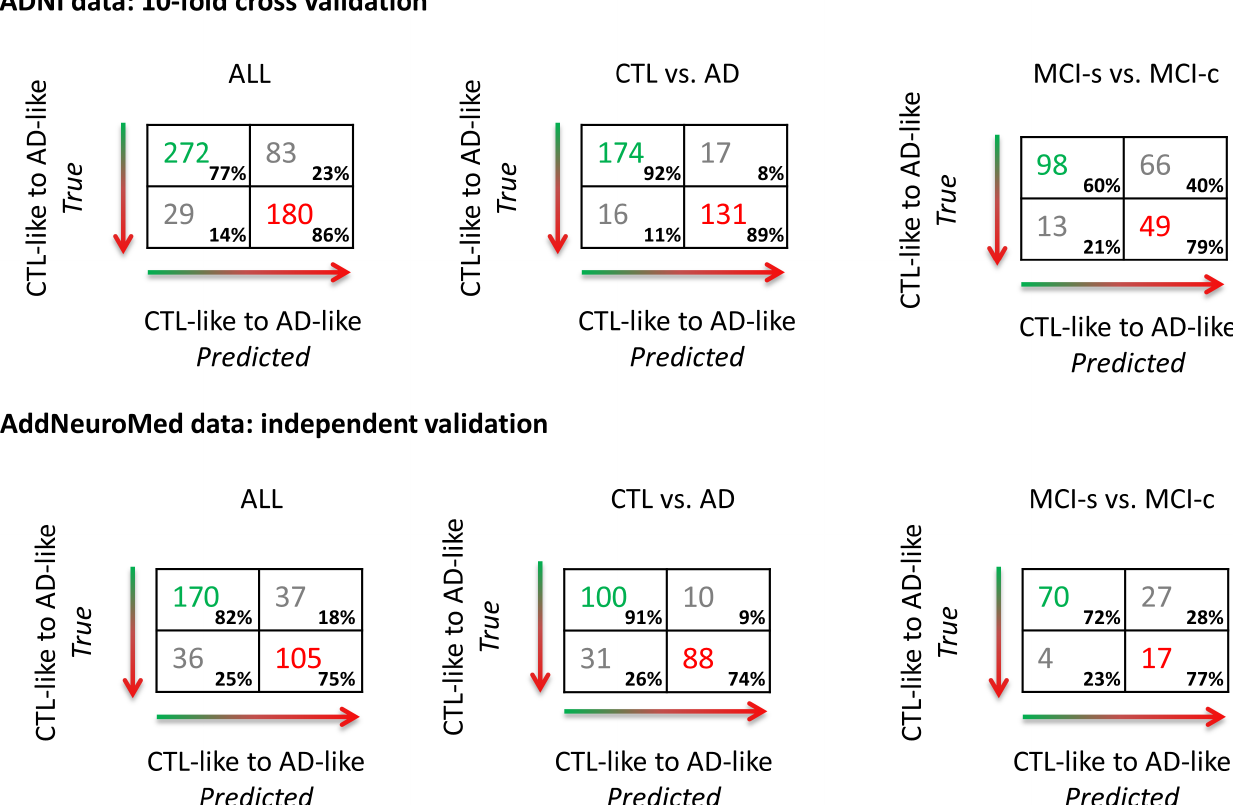
Figure 1. Confusion matrices for ordinal regression applied to two AD-related cohorts. The confusion matrix for the binarised CTL-like vs. AD-like (CTL and MCI-s vs. MCI-c and AD) is displayed on the left. For illustration purposes, on the right confusion matrices for two contrasts of interest: CTL vs. AD and MCI-s vs. MCI-c (note: training scheme is unchanged). The top panel displays the results achieved using 10-fold cross- validation on the ADNI dataset. The bottom panel displays the results achieved by applying the ordinal regression model trained on the ADNI dataset to the AddNeuroMed data set whereby the AddNeuroMed dataset represents an independent unseen validation of the performance of the method.